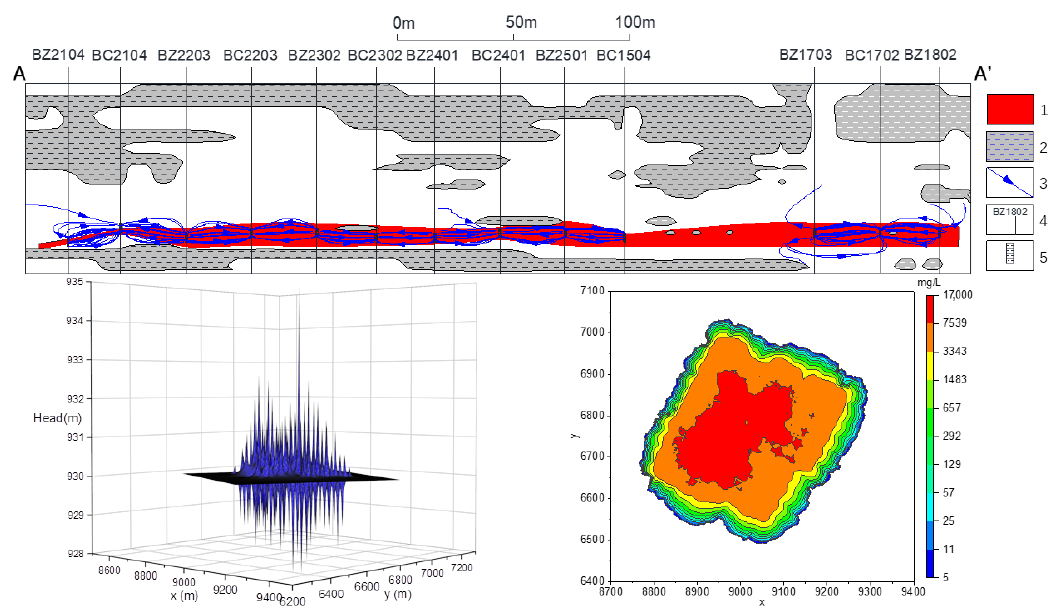
Figure 5. Simulated results of the flow field of in situ leaching uranium mining (Plan A). Note: The above ‐ the profile (A ‐ A’) of the flow field, and the location of the profile is shown in Figure 3 (1—The uranium ore body; 2—Mudstone; 3—Streamline and its direction; 4—Pumping and injection wells; 5—Filter); lower left—water level contour map of the mining areas; lower right—solute transport diagram of the mining